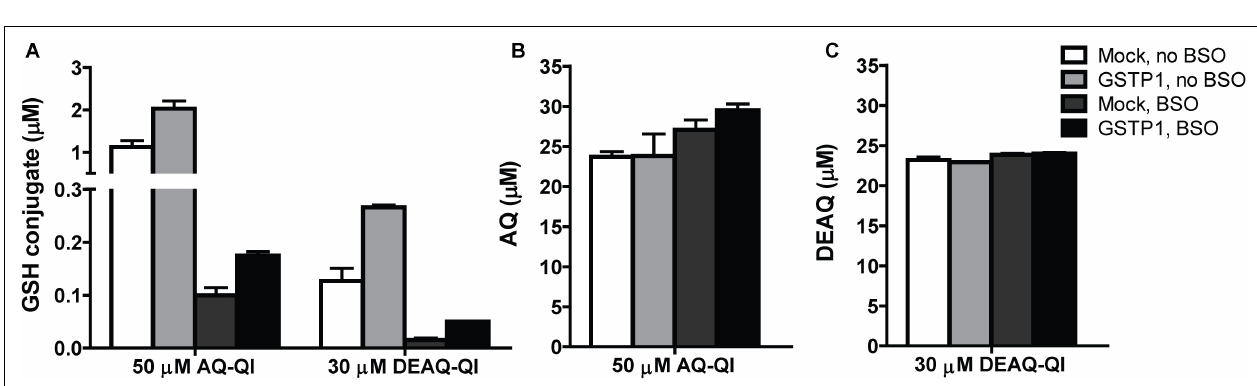
FIGURE 4 | Caspase 3 activity in mock- and GSTP1 -transfected HepG2 cells following a 2.5 h exposure to 50 µ M AQ-QI (A) or 30 µ M DEAQ-QI (B) with or without a 24 h pretreatment with 500 µ M BSO. Caspase 3 activity was used as measure for cell death by apoptosis and is presented as percentage relative to respective vehicle controls in mock-transfected cells. Each bar represents the mean ± SD from three independent experiments. Statistical significant differences with corresponding vehicle control are denoted with ‘a’ and with corresponding mock-transfected control are denoted with ‘b’ using the following p -values: ∗ p < 0.05; # p < 0.01; ¶ p < 0.001 (Student’s t -test).